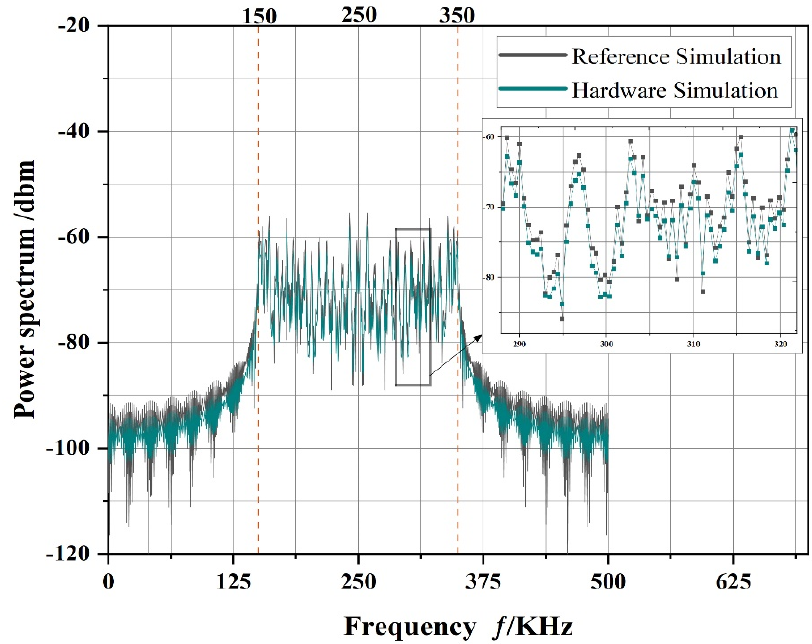
Figure 17. Signal power spectrum realized by MATLAB simulation and hardware.